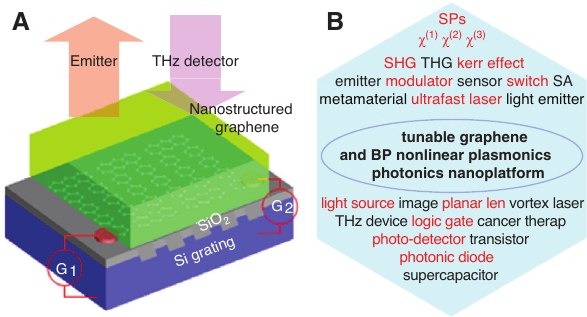
Figure 12: Tunable graphene and BP nonlinear plasmonics photonics nanoplatform. (A) The 2D material array chip applications including the bright visible or THz light emission, THz detector, light modulation, switches, photothermal therapy, biosensors, etc. (B) The illustration of tunable graphene and BP nonlinear plasmonics photonics nanoplatform with the various linear or nonlinear optical phenomenon and their